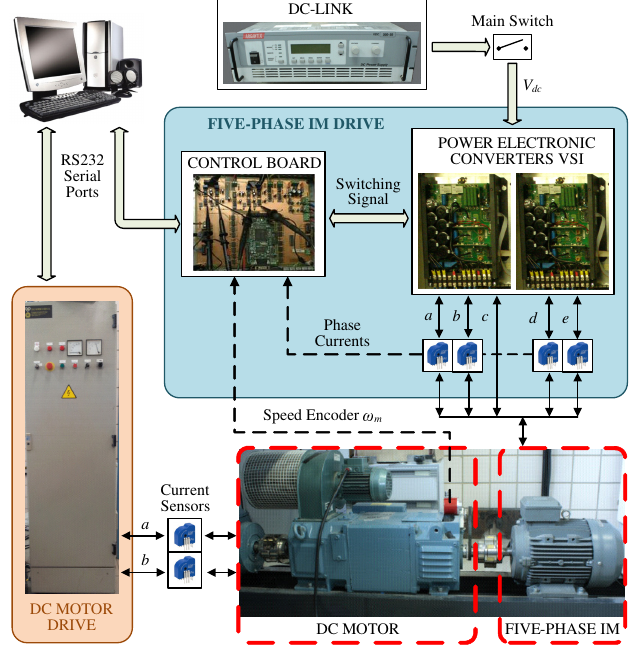
Figure 2. Experimental test rig. Table 1. Estimated parameters of the